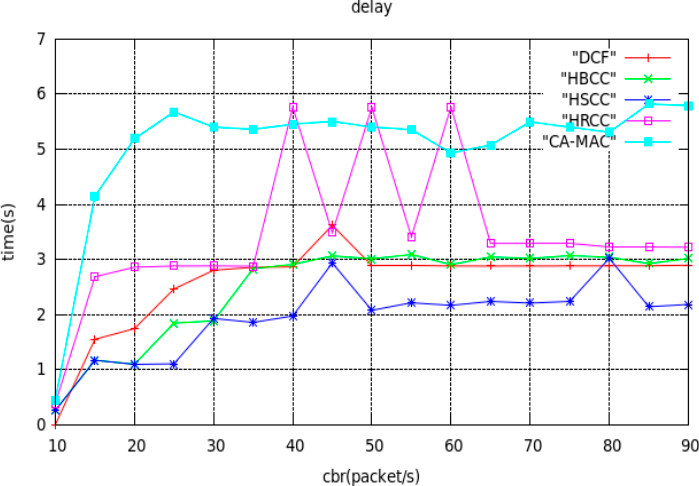
Figure 9. Curves of average end-to-end delay with network load.